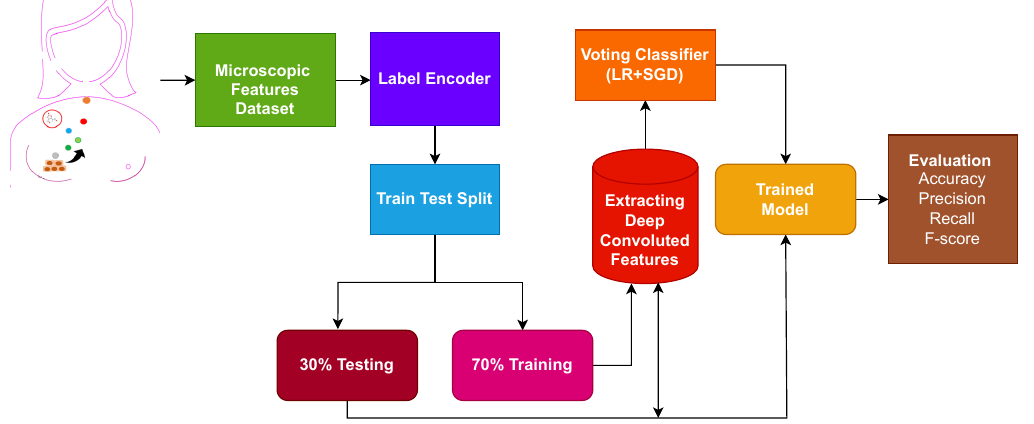
Figure 1. Workflow diagram of the adopted methodology.